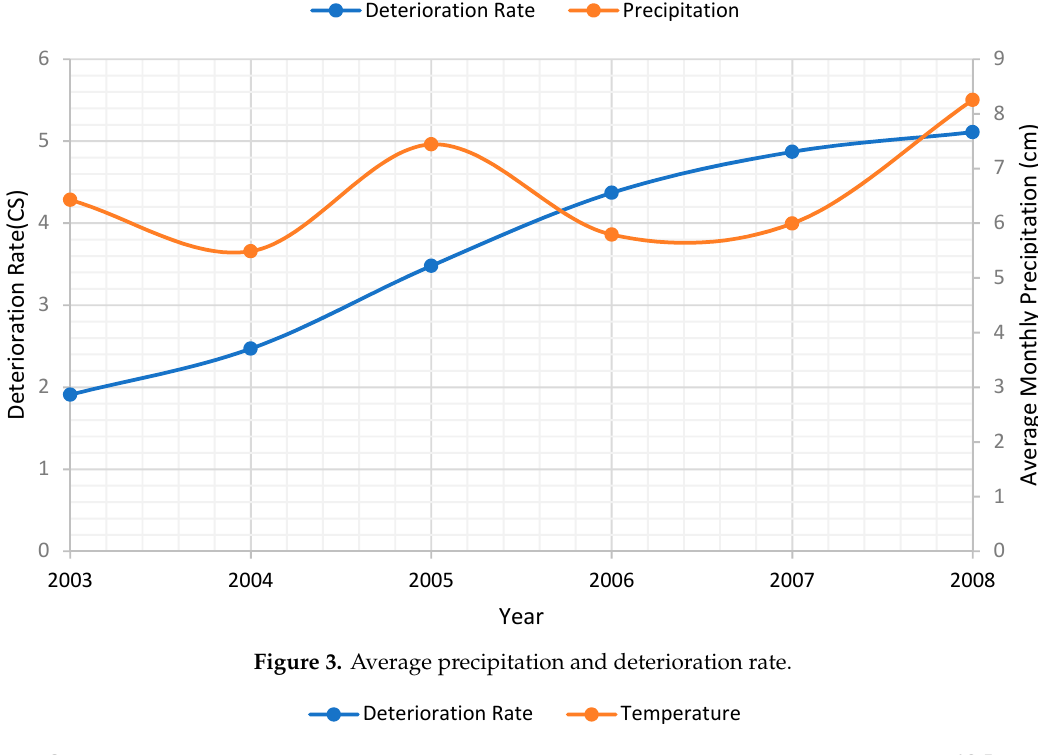
Figure 3. Average precipitation and deterioration rate.